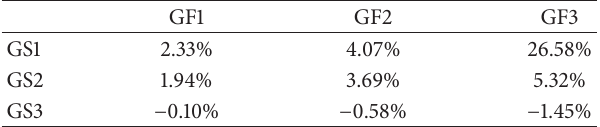
Table 3: Average increases of the flutter speeds for various GS and GF compared with the sandwich panel with no gradient